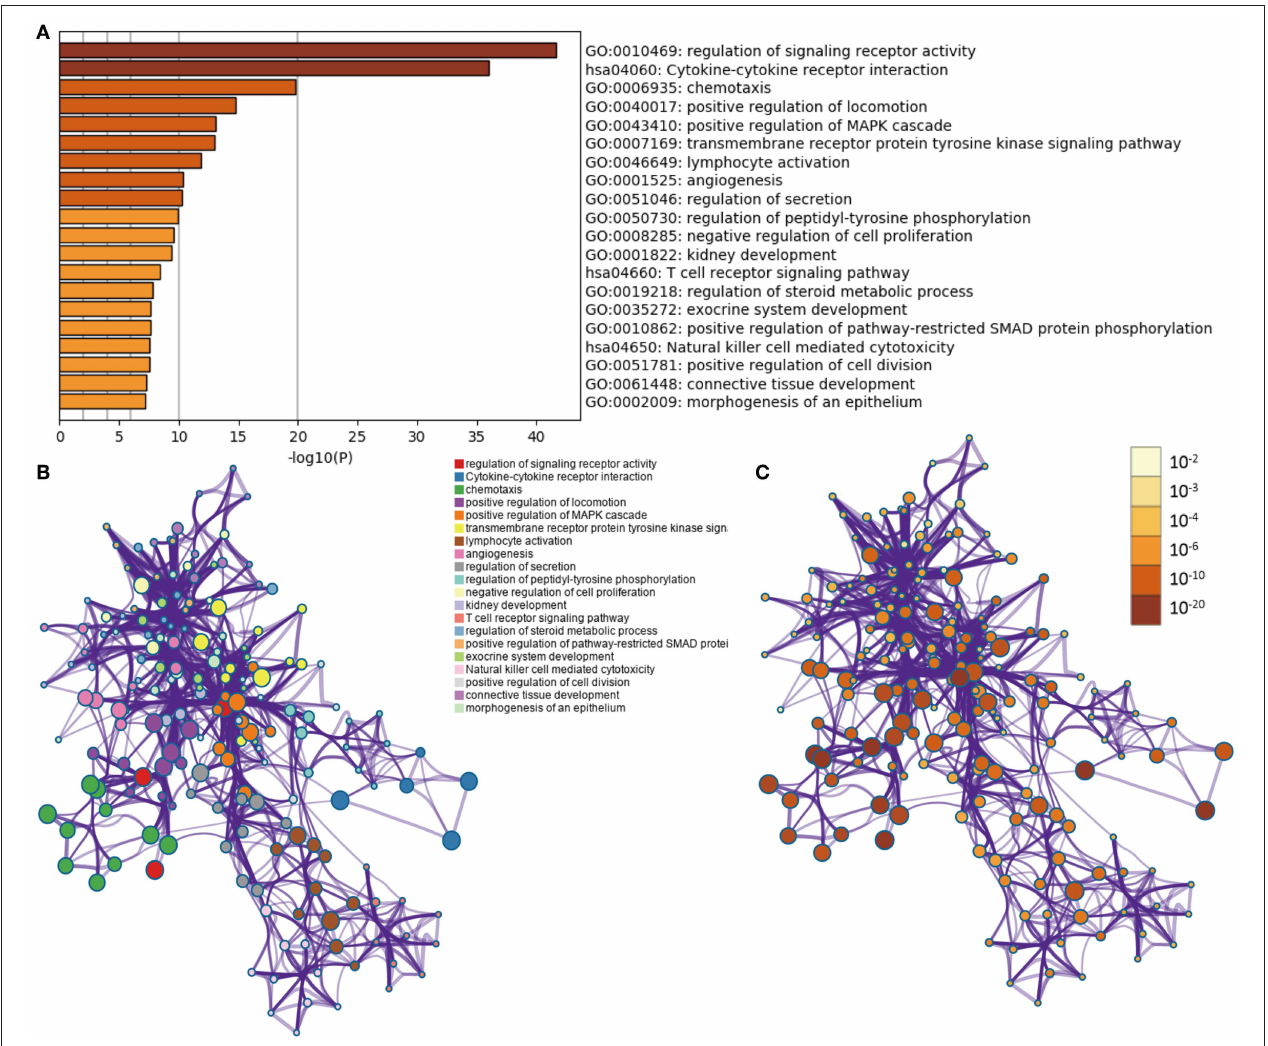
FIGURE 2 | Functional analysis of 88 IDH1-associated immune genes. (A) Heatmap of enriched terms across input gene lists, colored by P -values. Network of enriched terms: (B) colored by cluster ID, where nodes that share the same cluster ID are typically close to each other; (C) colored by p -value, where terms containing more genes tend to have a more significant P